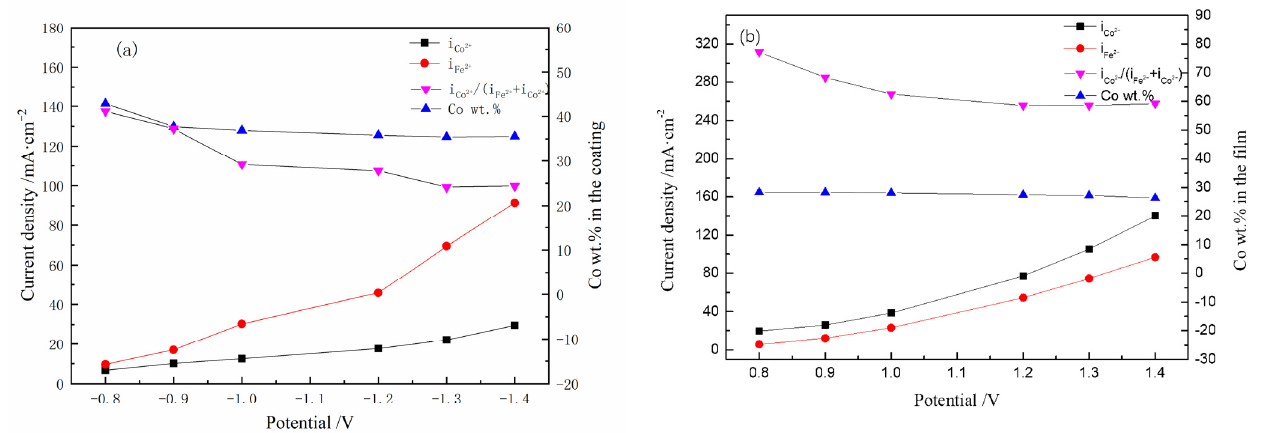
Figure 10. ( a ) Relations between i Co2+/(Co2++Fe2+) and the mass fraction of Co in the fi lm without out (NH 4 ) 2 SO 4 ; ( b ) Relation between i Co 2+ /(Co 2+ +Fe 2+ ) and the mass fraction of Co in the film (NH 4 ) 2 SO 4 ; ( b ) Relation between i Co2+/(Co2++Fe2+) and the mass fraction of Co in the fi lm with (NH 4 ) 2 SO 4 . with (NH 4 ) 2 SO 4 The e ff ect of the ratio of Co 2+ /(Fe 2+ + Co 2+ ) in the solution on the Co mass fraction in